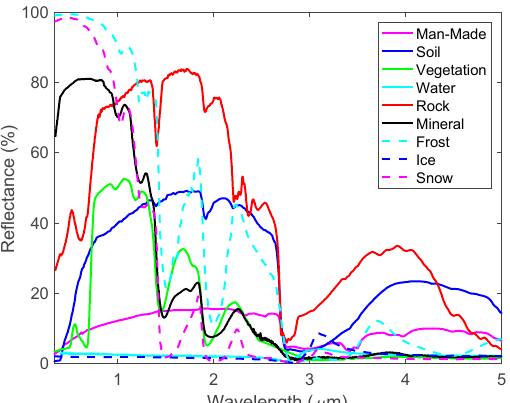
Figure 1. The typical reflective spectra for various land surface materials from the ASTER Spectral Library. They were used to build the land surface bidirectional reflectance distribution functions (BRDFs).